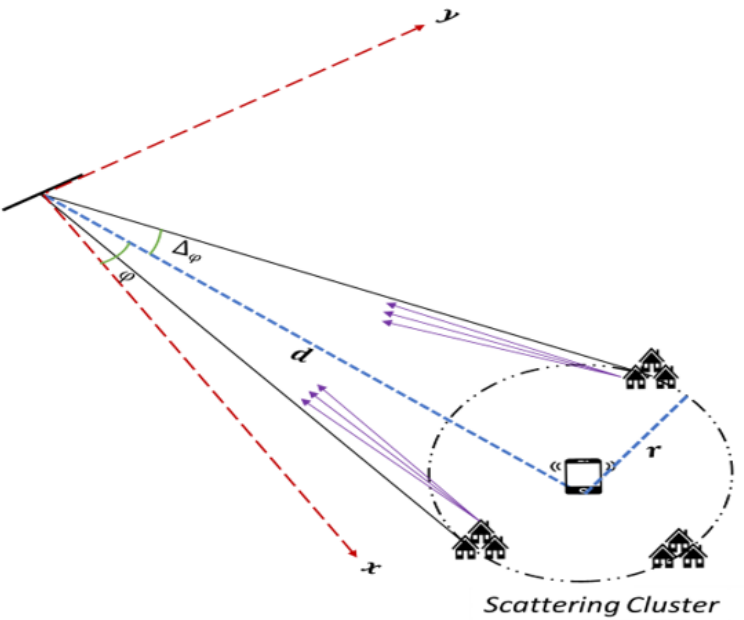
Figure 3. Three-dimensional physical channel model, where the scatterers are distributed around the user terminal (UT). Each path is characterized by two angles: the azimuth ( ϕ i ) and elevation ( θ i ). The horizontal angular ASD defined as